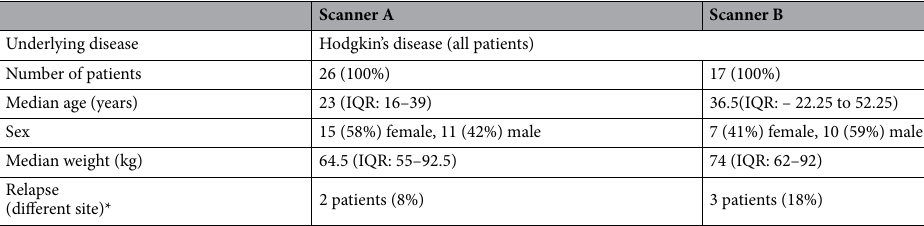
Table 1. Details of the patient population. Details of the included patients. Percentages of the patients are listed per scanner and may not total 100 due to rounding. IQR interquartile range. *Patients with relapse at a different site (if a relapse occurred at a new site, we classified the examination as "initial").